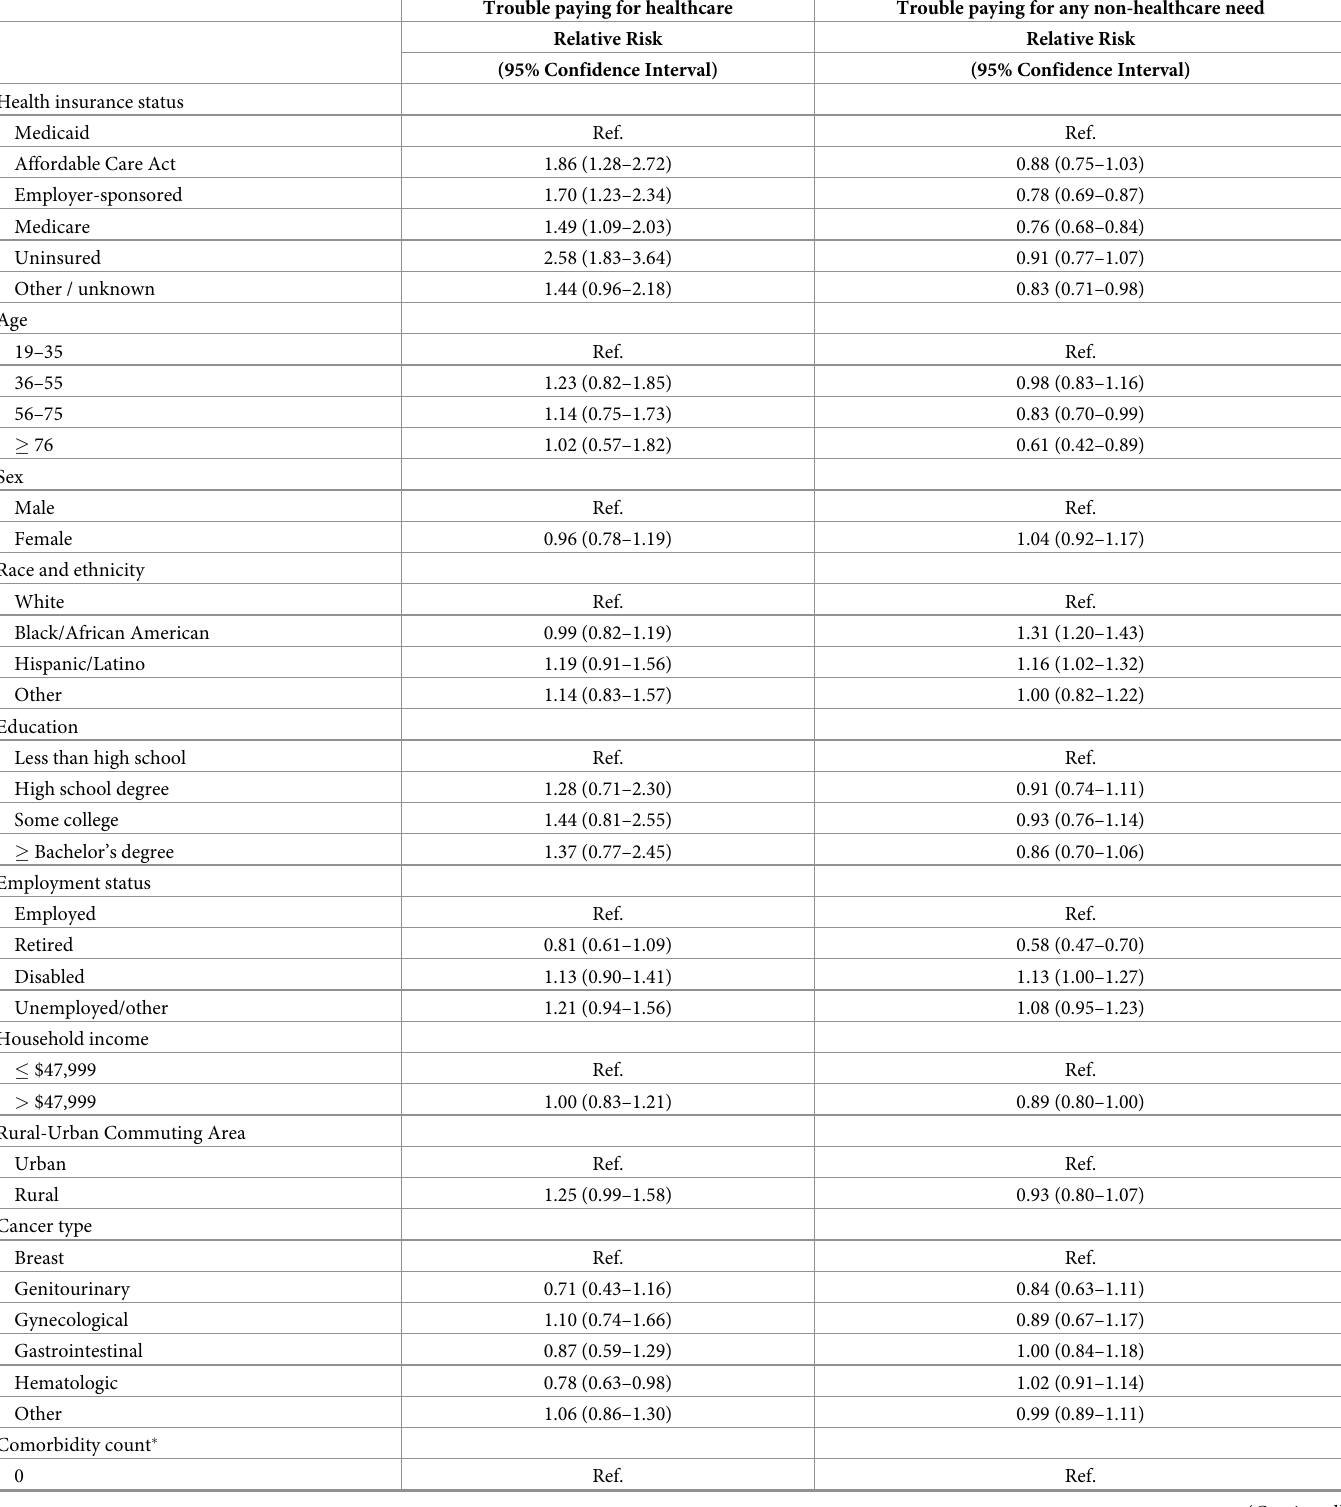
Table 2. Adjusted model results estimating relative risk of trouble paying for healthcare or any non-healthcare need in cancer survivors (N =